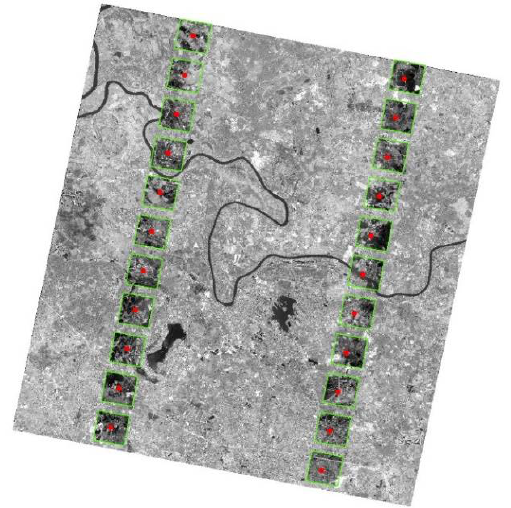
Figure 2. An example of laser ground spots; laser footprint images and high-resolution